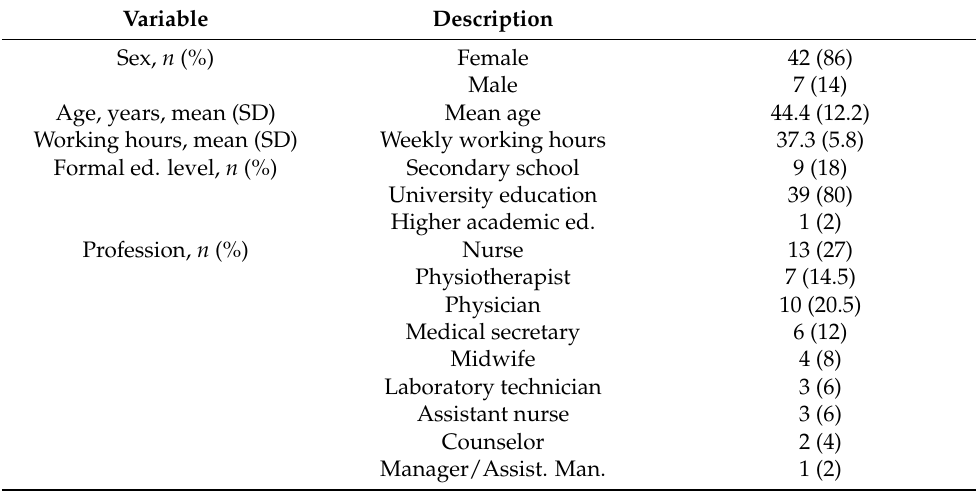
Table 1. Descriptive data, study participants ( n =